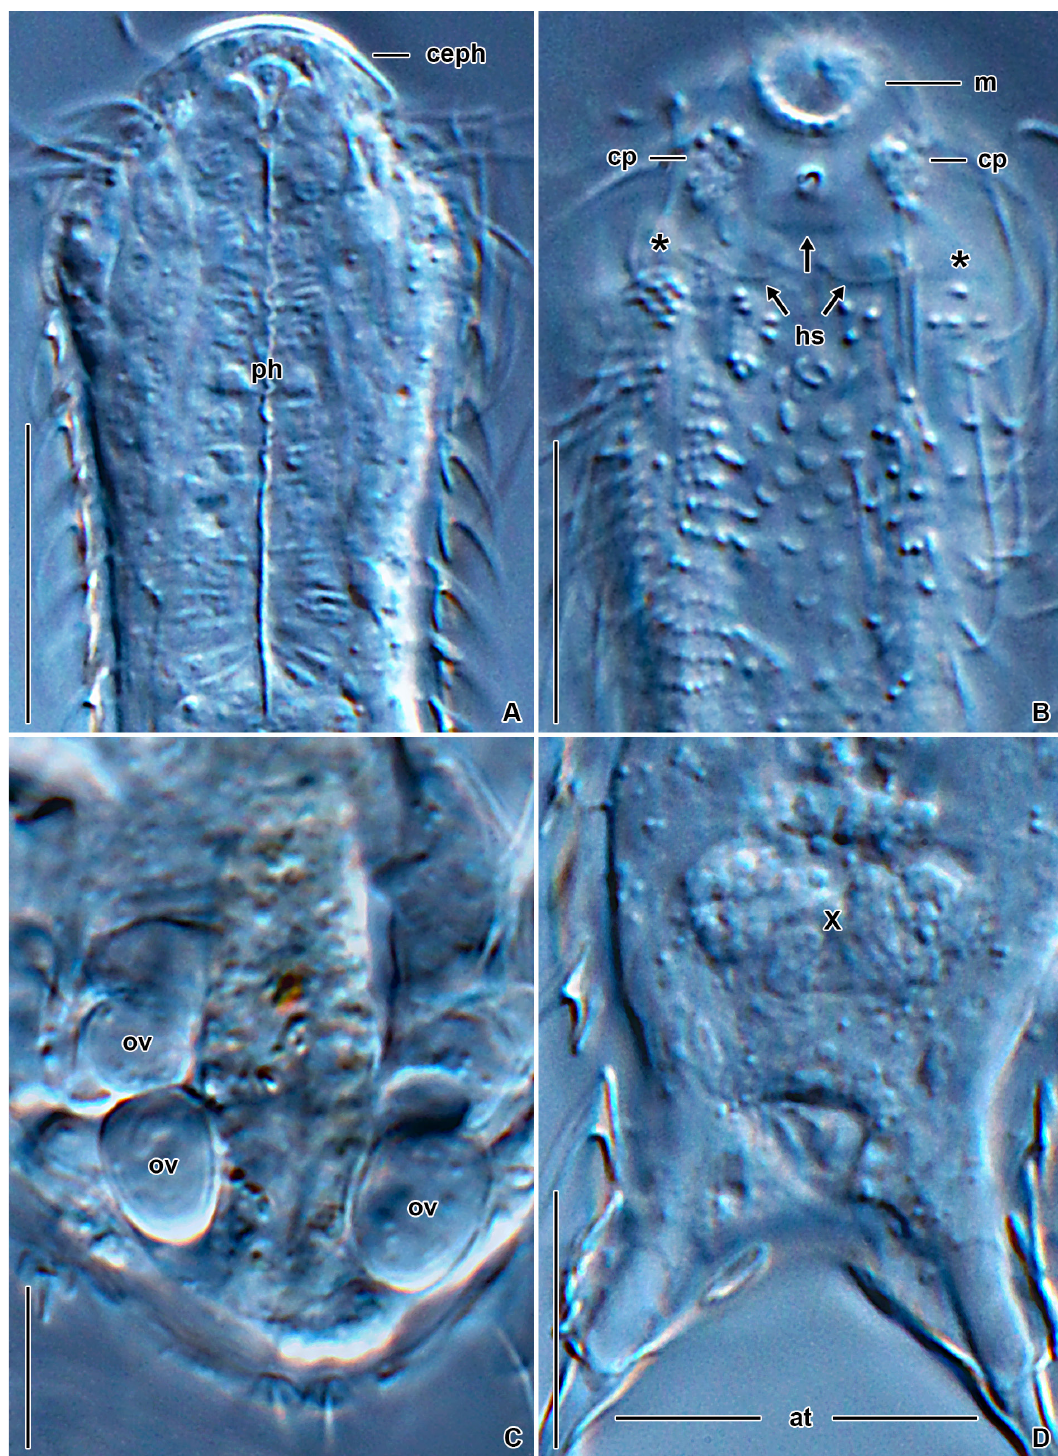
Fig. 21. Chaetonotus ( Hystricochaetonotus ) optabilis sp. nov., differential interference contrast. A–B, D . Paratype (CU-FNS-05-03-20-3/PA-2). C . Holotype (CU-FNS-05-03-20-1/HO). A . Detail of the anterior body region. B . Ventral view of the head region. Asterisks mark the beginning of the ventral ciliary bands, arrows mark the cuticular structures of the hypostomium. C‒D . Details of the posterior body region, showing the ovaries and the organ X. Scale bars = 10